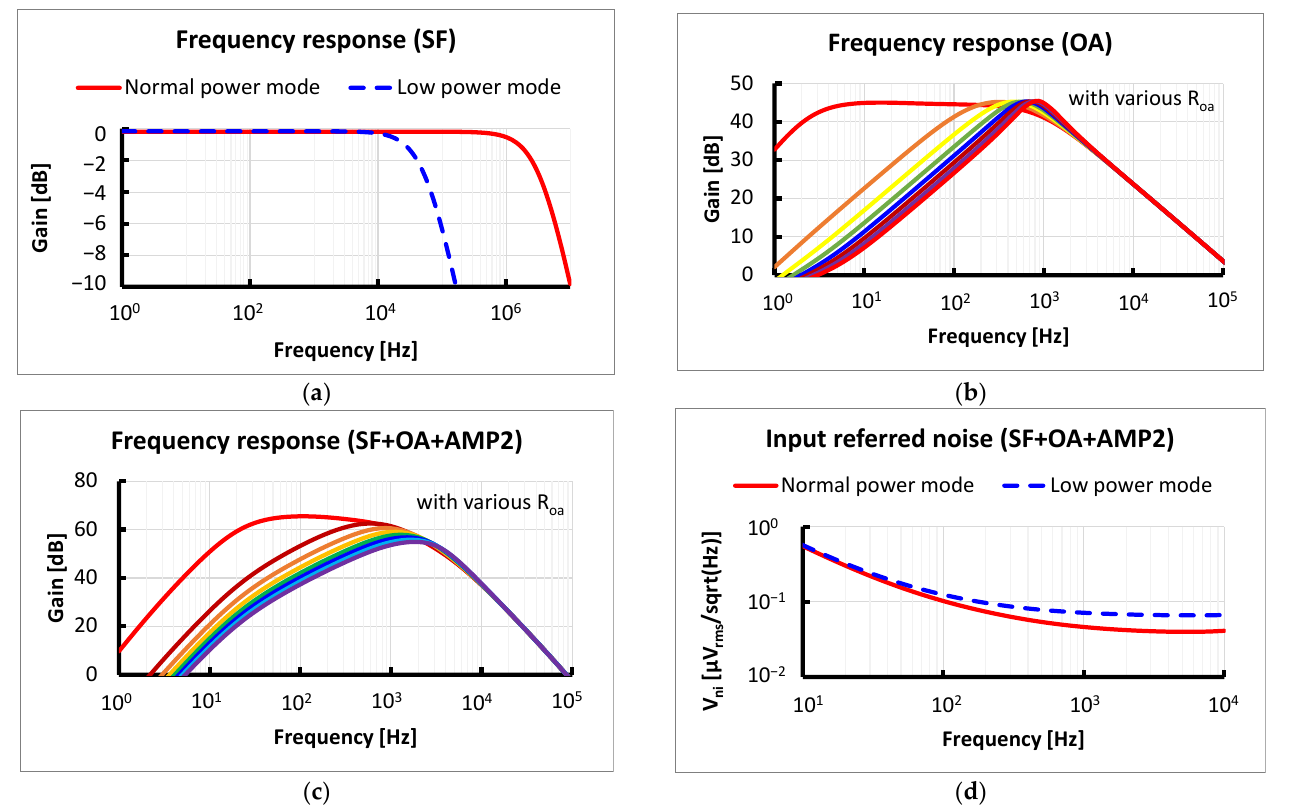
Figure 15. Characteristics of analog blocks: ( a ) Frequency response characteristics of SF; ( b ) Frequency response characteristics of OA; ( c ) Frequency response characteristics of SF + OA + AMP2; ( d ) Noise characteristics of SF + OA + AMP2.